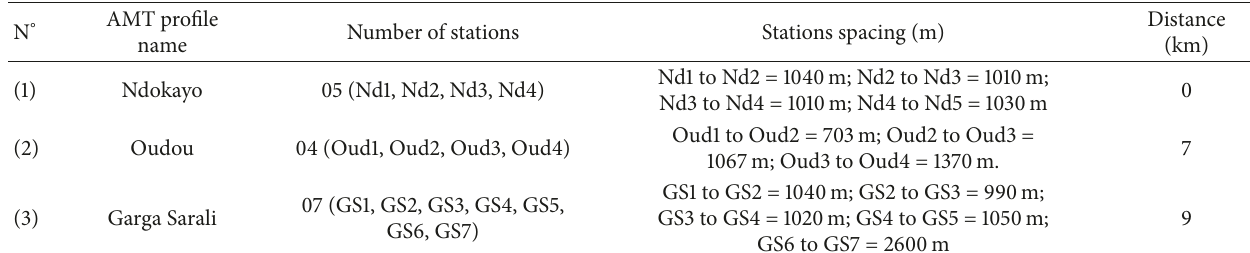
Figure 5: Schematic diagram of an AMT measurement site (reproduced from Lahti, 2015, under the public domain). Table 1: Distances between profiles and the base profile Ndokayo.